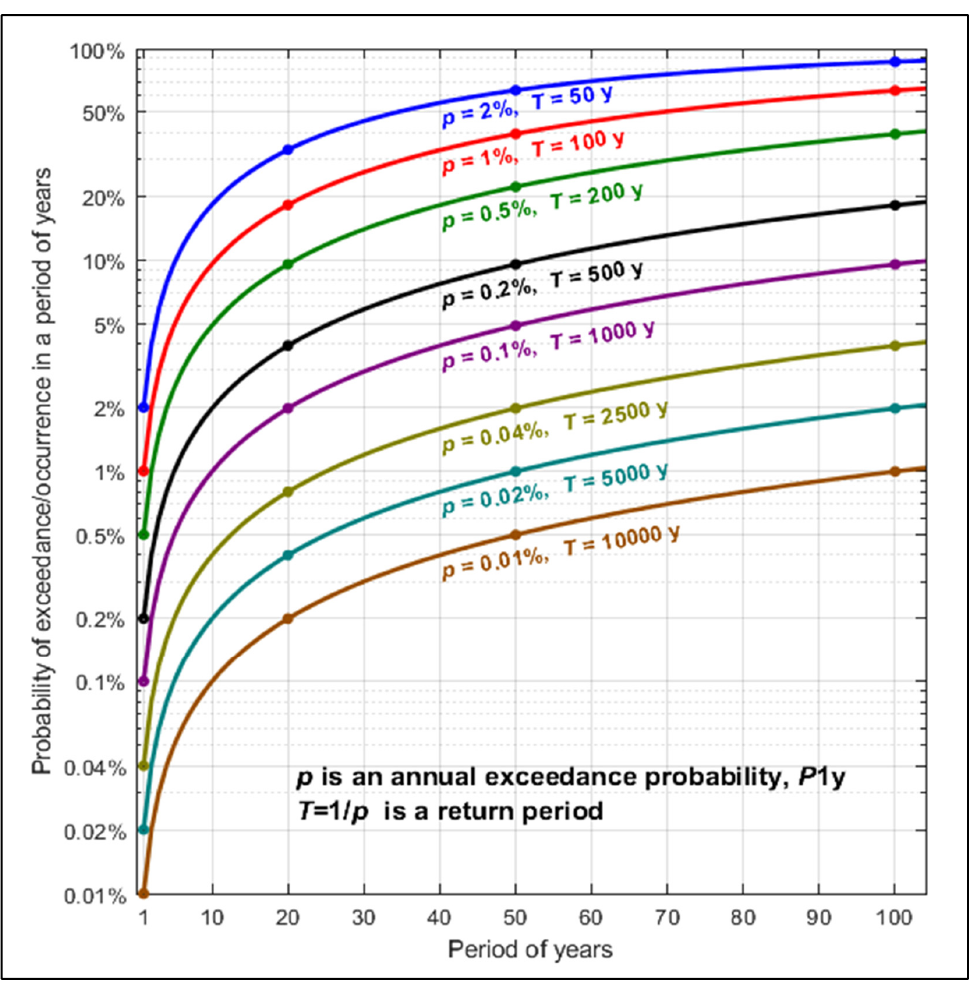
Figure 1. Exceedance probabilities for periods of years, from 1- to 100-yr period.